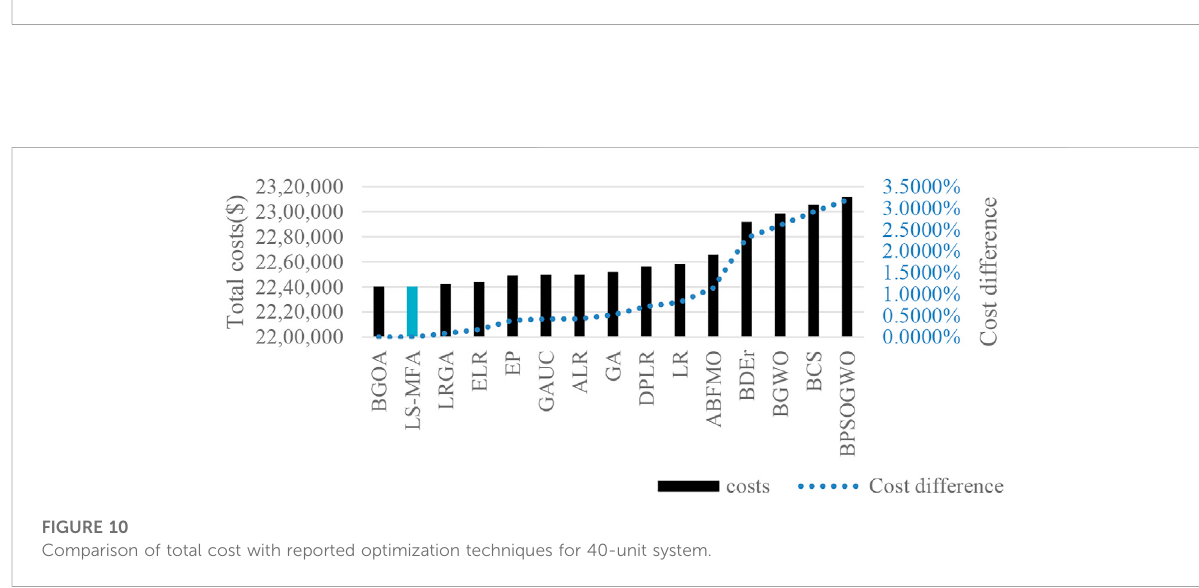
FIGURE 9 Comparison of total cost with reported optimization techniques for 20-unit system.